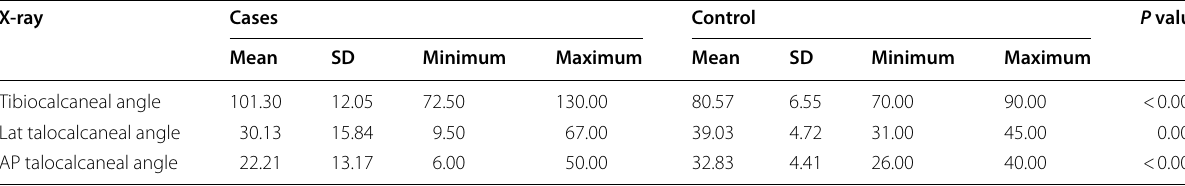
Table 2 Comparison of the radiographic parameters between cases and controls